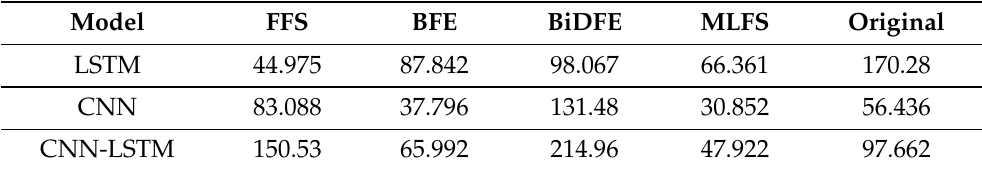
Table 17. Deep learning models computational time.